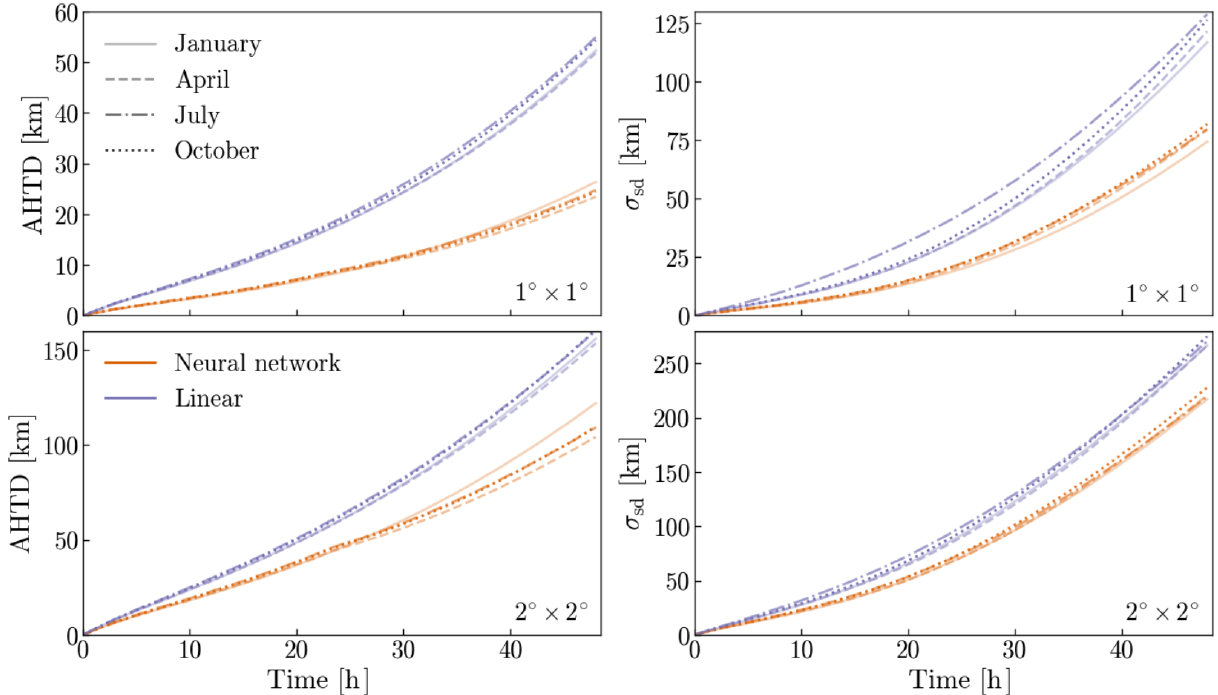
Figure 6. Absolute horizontal transport deviations (Eq. 3) and standard deviations of 10 million particles advanced with FLEXPART, using two different degraded resolution data (as described in Sect. 3.1) and two interpolation methods, as compared to the same particles advanced using the original full resolution data. The top panels show the results for the degraded 1 ◦ × 1 ◦ resolution data (neural network interpolation using model2 ), and the bottom panels those of the degraded 2 ◦ × 2 ◦ resolution data (neural network interpolation using model4 ). Orange lines show the AHTD (left panels) and standard deviation (right panels) of particles advanced using the neural network, and purple lines show these for the linearly interpolated data. Results for different seasons are shown with different line